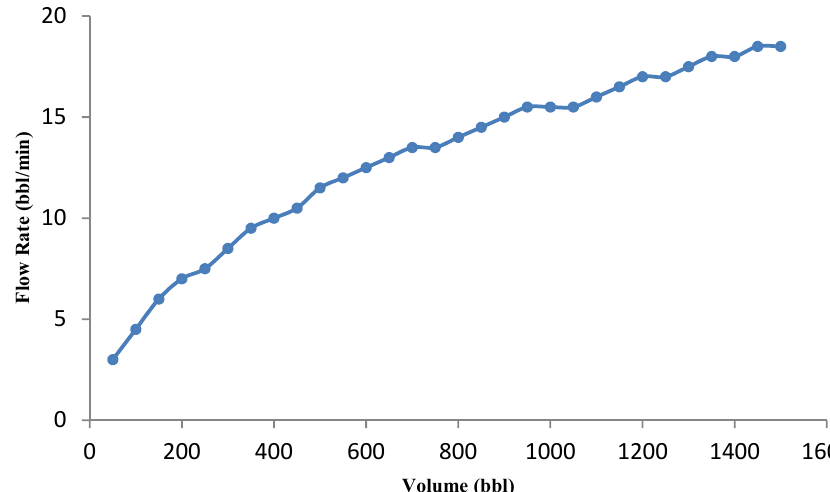
Figure 9. Optimal flow rate changes versus acid